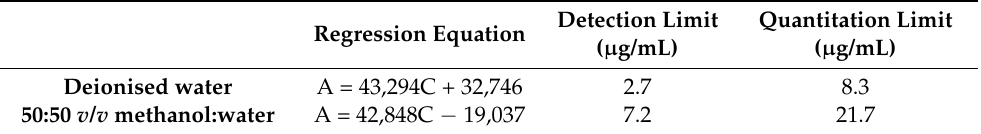
Table 2. HPLC calibration curves, detection limit, and quantitation limit for HCQS from 6.25 to 1000 µ g/mL.